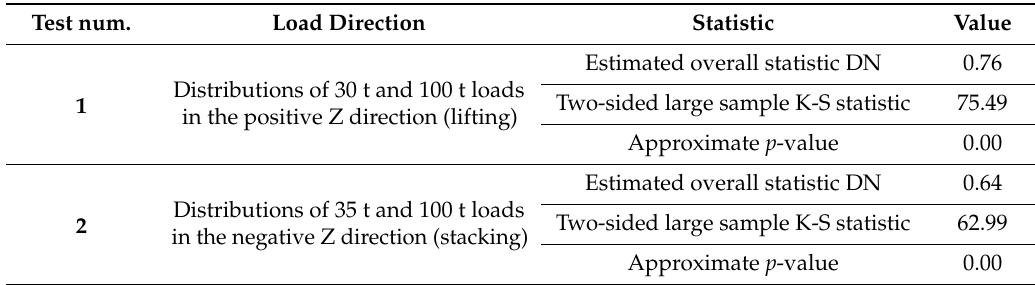
Table 7. Kolmogorov–Smirnov (K-S)